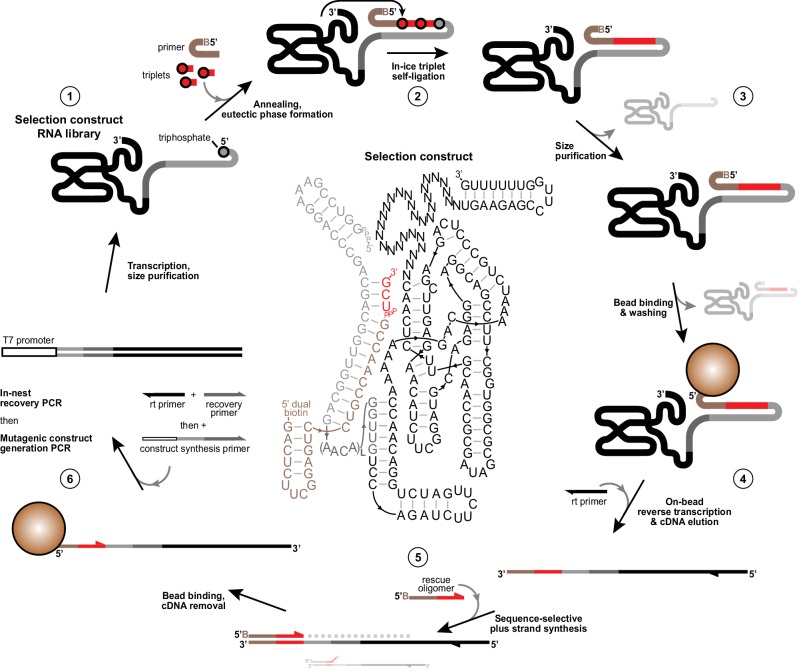
Selection scheme for in vitro evolution of triplet polymerase activity.Illustration of the in vitro evolution strategy to enrich iterative templated ligase activity from libraries of selection constructs. Centre, an example selection construct is shown comprising Zcore with a 3’ 30 nt random domain followed by a fixed hairpin-forming reverse transcription site (1). This construct is flexibly tethered at its 5’ in cis (Tagami et al., 2017; Attwater et al., 2010) (via L repeats (3-8) of a flexible AACA linker) to a template region (grey) bound to 5’-dual biotin modified primer (tan). This construct requires successive polymerisation of two pppUCG triplet substrates (red) in −7˚C ice followed by self-ligation to its triphosphorylated 5’ terminus to attach itself to the biotinylated primer (2). Active triplet polymerases are then identified and size-purified by denaturing PAGE to deplete unreacted ribozymes and primer (3), then captured on streptavidin beads and subjected to a denaturing wash to ensure covalent linkage to primer. Remaining dual-purified bead-linked ribozymes were then reverse transcribed (4). cDNAs were eluted with NaOH and neutralised, before acting as templates for ‘+’ strand DNA synthesis from 5’ biotinylated ‘rescue’ oligonucleotides that only prime correctly on the complete synthesised sequence (5), ensuring that constructs that deviated from the specified templated triplet polymerization fail to prime on cDNA preventing their ‘+’ strand synthesis. ‘+’ strands were then captured on fresh streptavidin beads, stripped of cDNAs, reamplified and diversified to generate selection construct for a new round of selection (6). See Materials and Methods for protocol details and Figure 1—source data 1, Figure 2—source data 1, Figure 4—source data 1 and Supplementary file 3 for oligonucleotides used in selections.